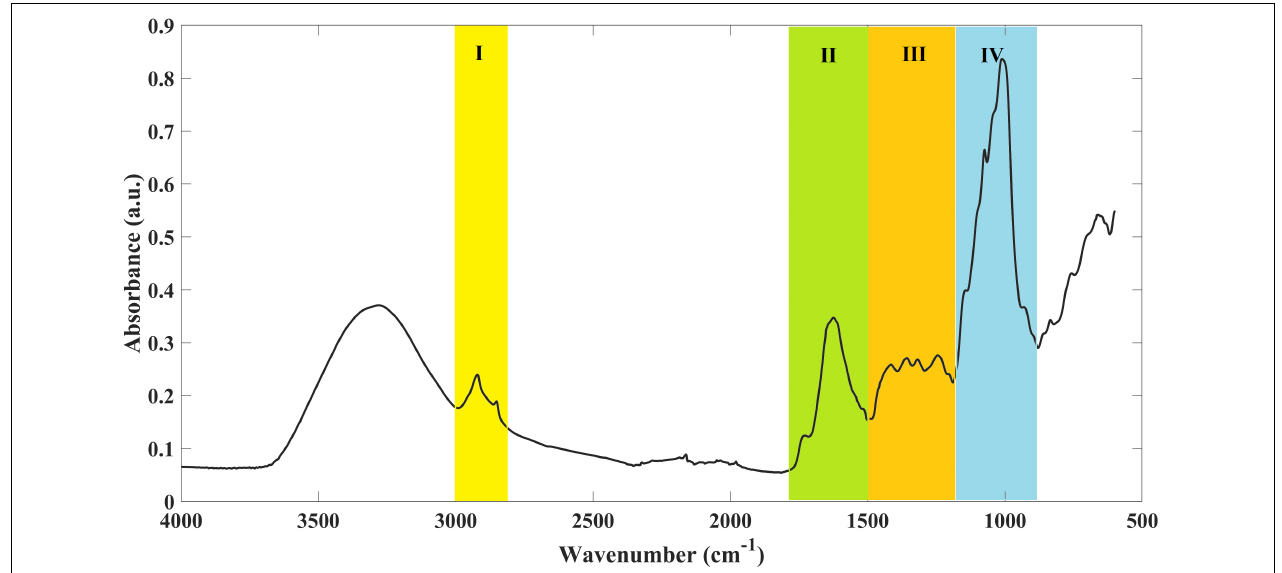
FIGURE 4 | Example of an infrared spectrum of L. minor . Four major regions (I–IV) were identified, representing major classes of compounds.